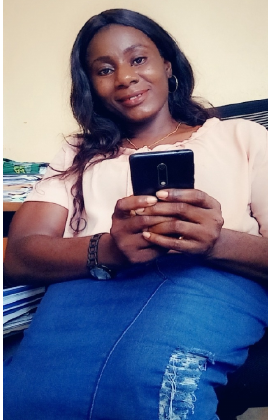
(Rose Dargbe, younger female, Liberia)